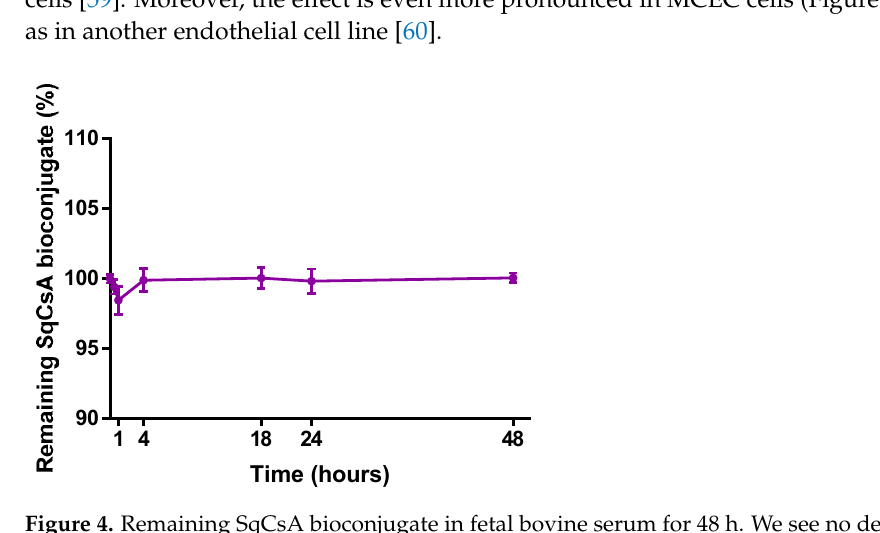
Figure 4. Remaining SqCsA bioconjugate in fetal bovine serum for 48 h. We see no degradation of the bioconjugate. Data represent mean ± SD of three replicates.